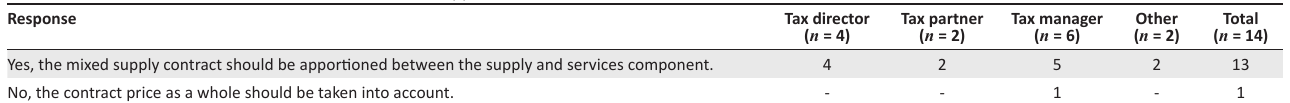
TABLE 10: Results of whether a mixed contract should be apportioned. Response